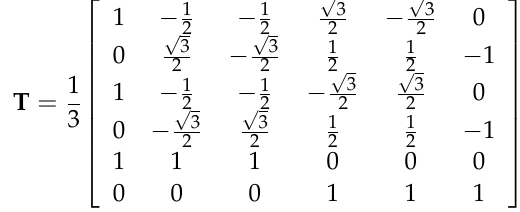
Figure 2. Mapping of the voltage vectors imposed by the 2L-VSIs to a six-phase machine with a 1N configuration: ( a ) α - β ; ( b ) x - y ; ( c ) z 1- z 2 subspaces. Considering the vector space decomposition (VSD) matrix in (8) and the rotational matrix R in